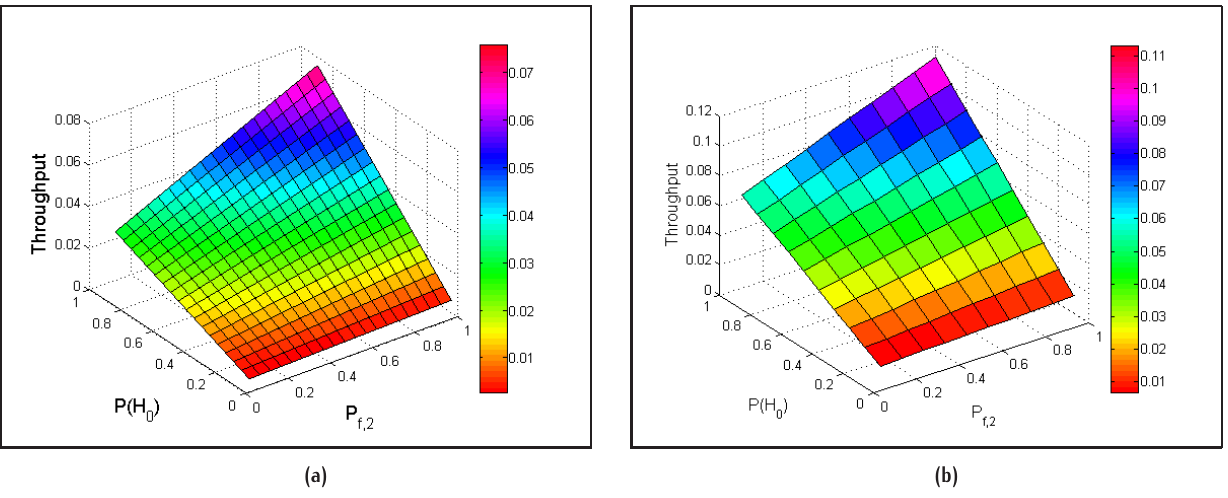
Figure 5. Combined effect of primary user’s activity and false alarm probability of CRN CR networks with equal access (a) Gaussian interference (b) Nakagami-m interference were used: d 0 = 100 m , R = 50, P = 30 dBm , P PU